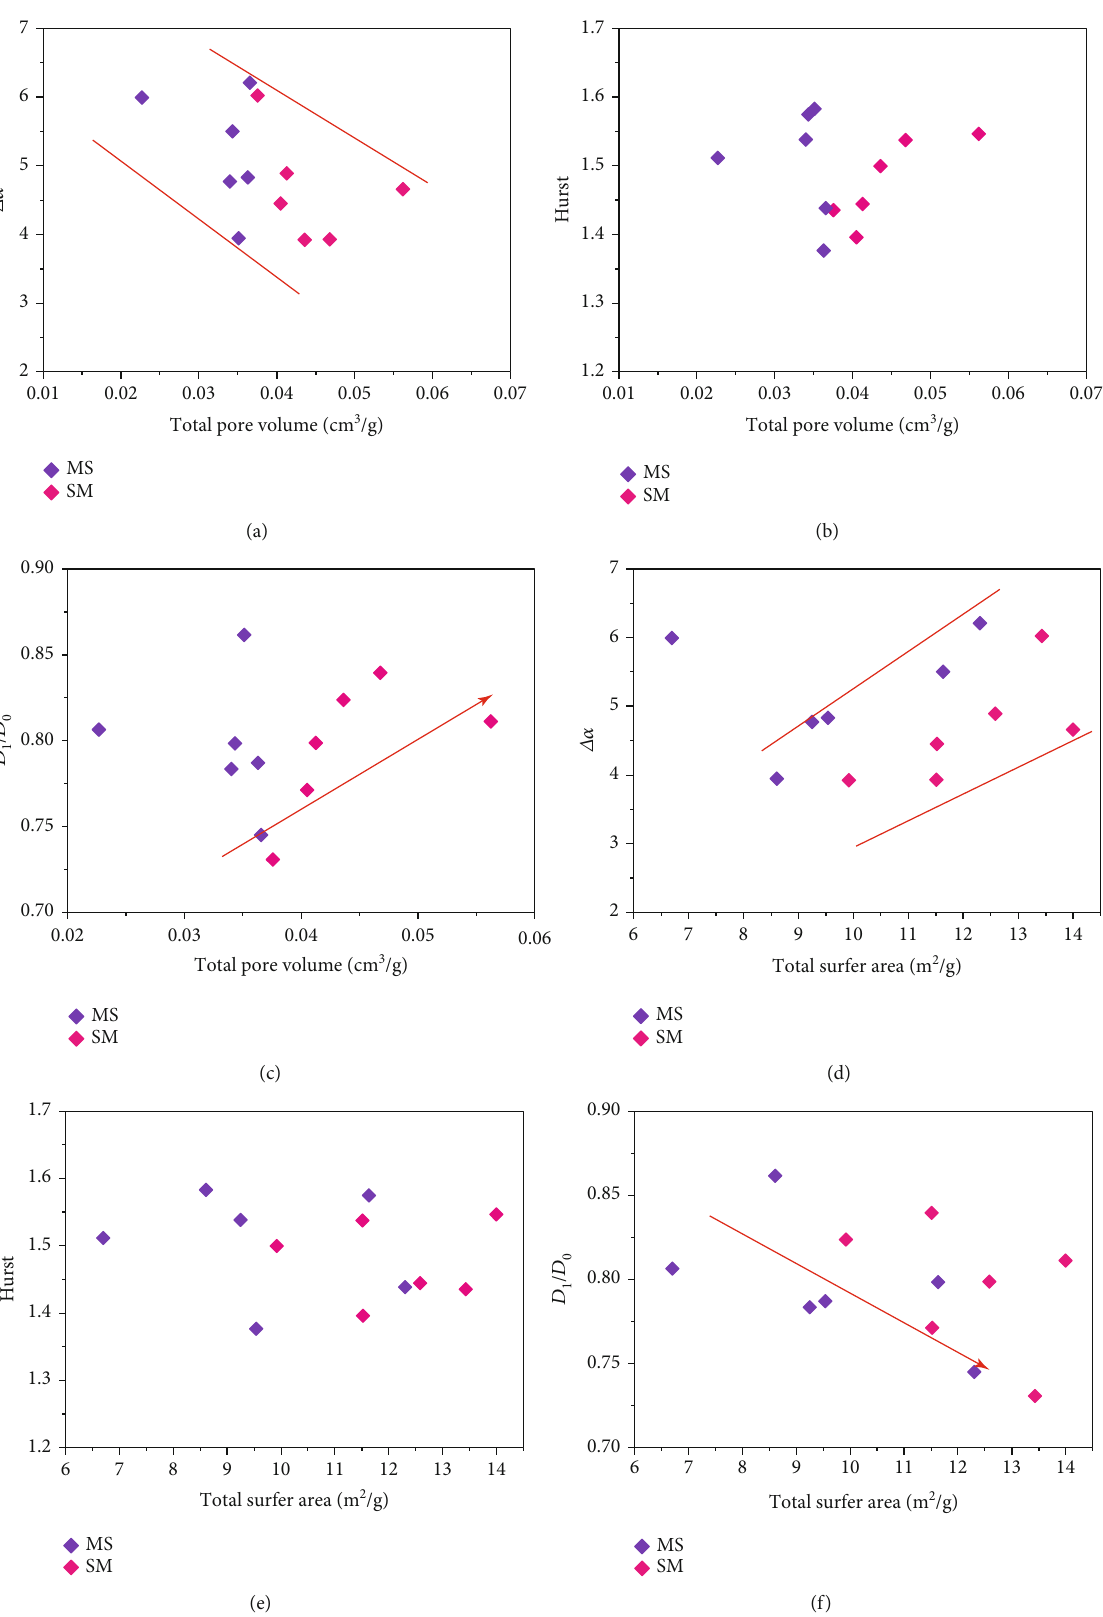
/ D and total pore volume (c), total 1 0 / D 1 0